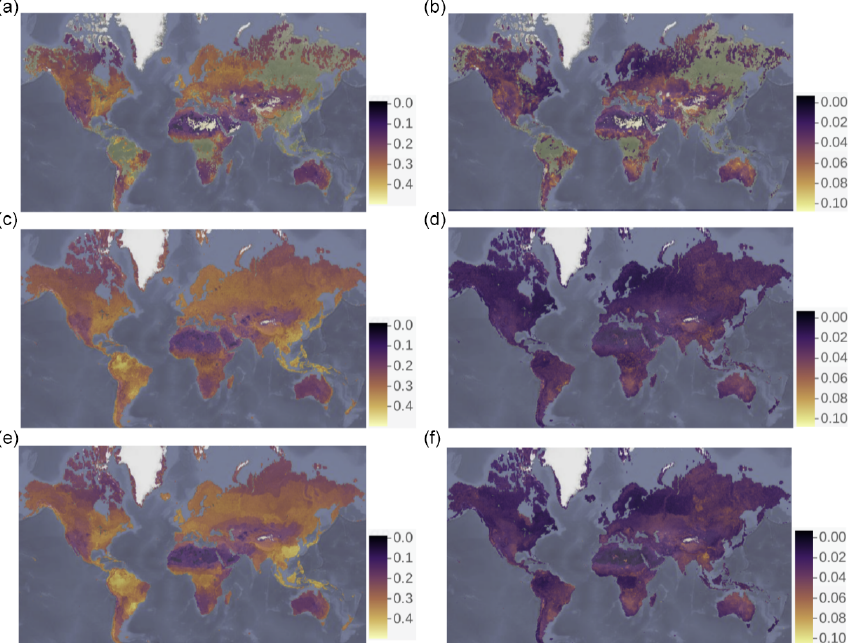
Figure 4. Soil moisture mean (a) and variance (b) of the ESA-CCI soil moisture product v4.5 between 1991 and 2018. Prediction of soil moisture (c) and prediction variance (5000 × 5, d ) based on topographic terrain parameters. Prediction of soil moisture (e) and prediction variance (f) based on bioclimatic and soil type classes. Units: m 3 m − 3 .